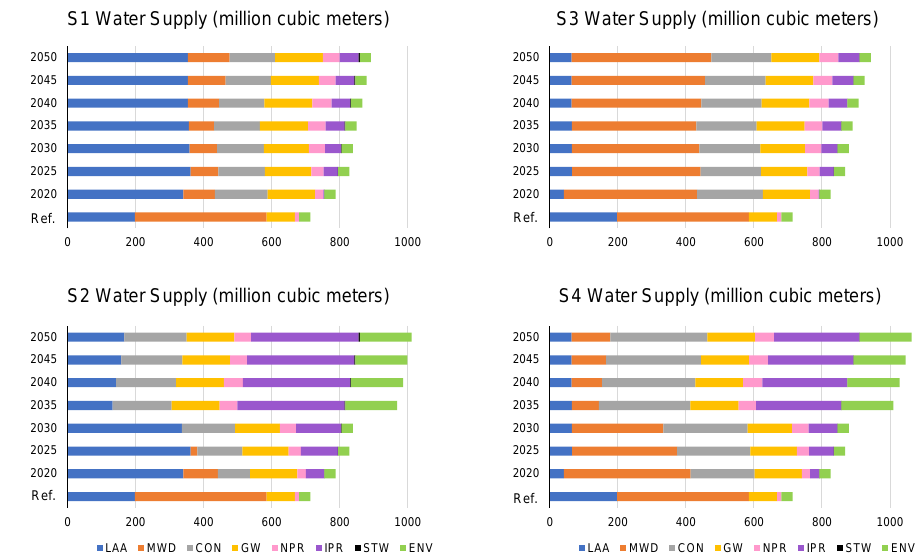
Figure 3. Historical reference year and projected water supply portfolios in S1–S4. Water supplies from LAA (Los Angeles Aqueduct), MWD (Metropolitan Water District), CON